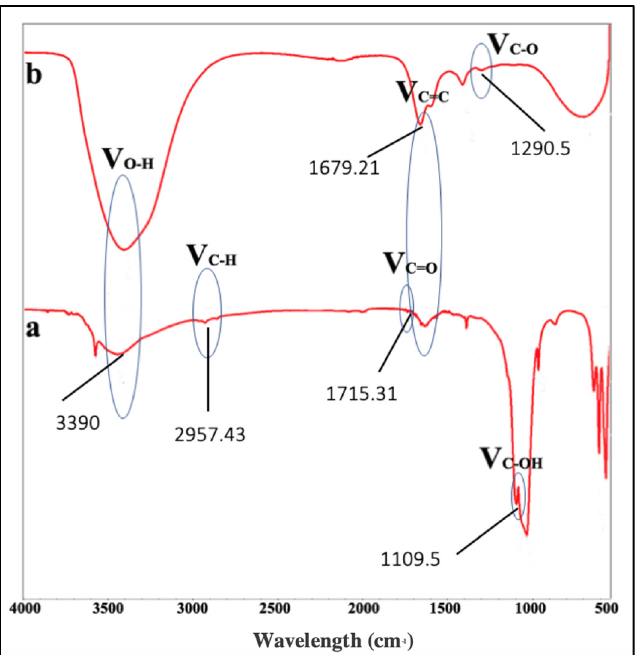
Figure 1. FTIR evaluation of citric acid and graphene oxide (GO). Line ( a ) shows the characteristic of the C=O stretch of the carboxylic acid group in citric acid. Line ( b ) presents the oxide functional groups in the synthesized GO and confirms the successful carbonization of citric acid into graphite oxide.